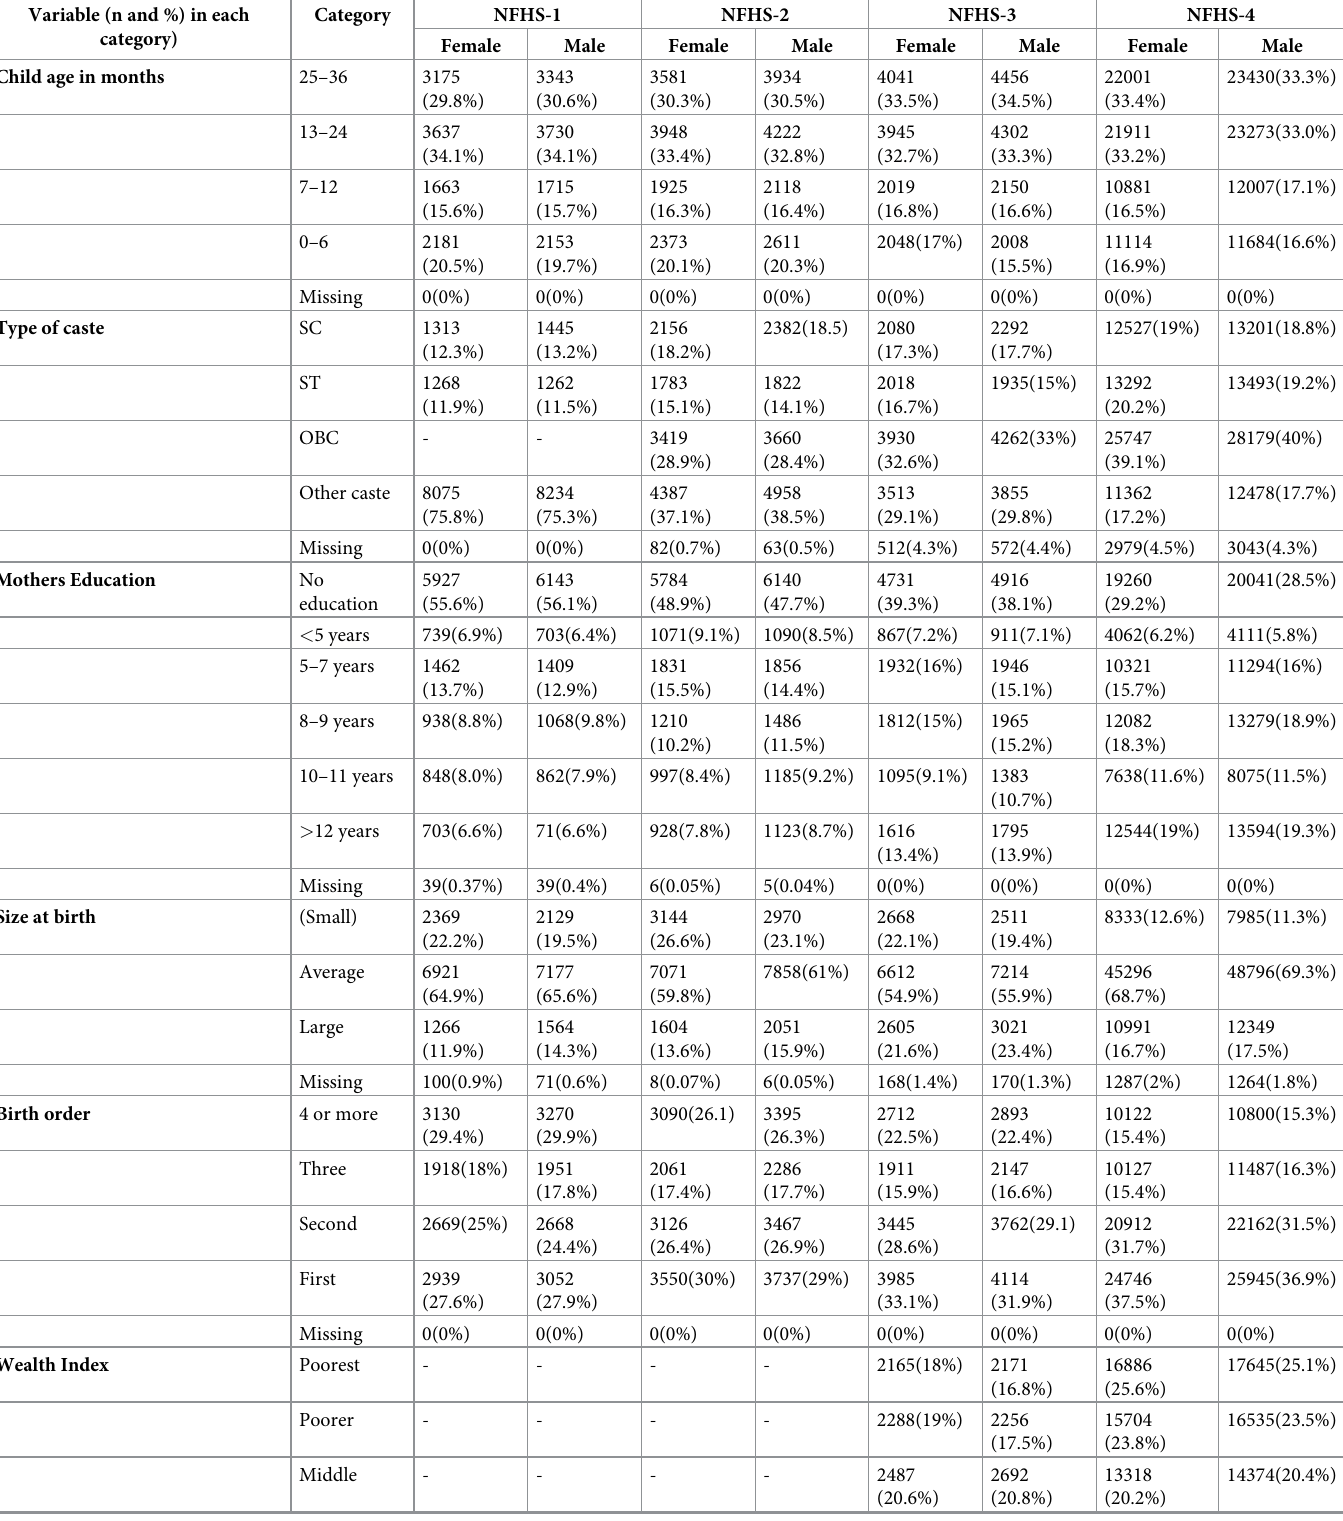
Table 1. Descriptive statistics and prevalence of stunting children aged 0–36 months by factors at different categories based on (NFHS- 1, 2, 3, 4) data. Variable (n and %) in each